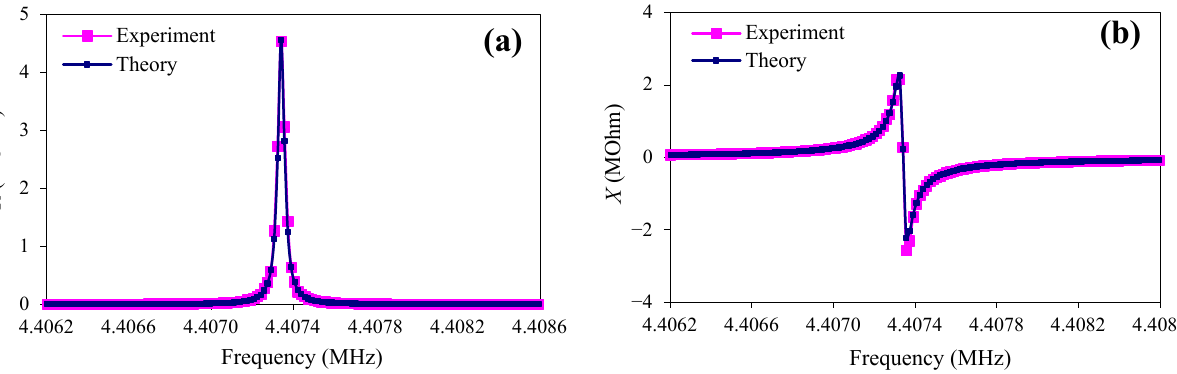
Figure 6. The frequency dependences of the real ( a ) and imaginary ( b ) parts of the electrical impedance of the AT-quartz resonator without load (pink—experiment; blue—theory).